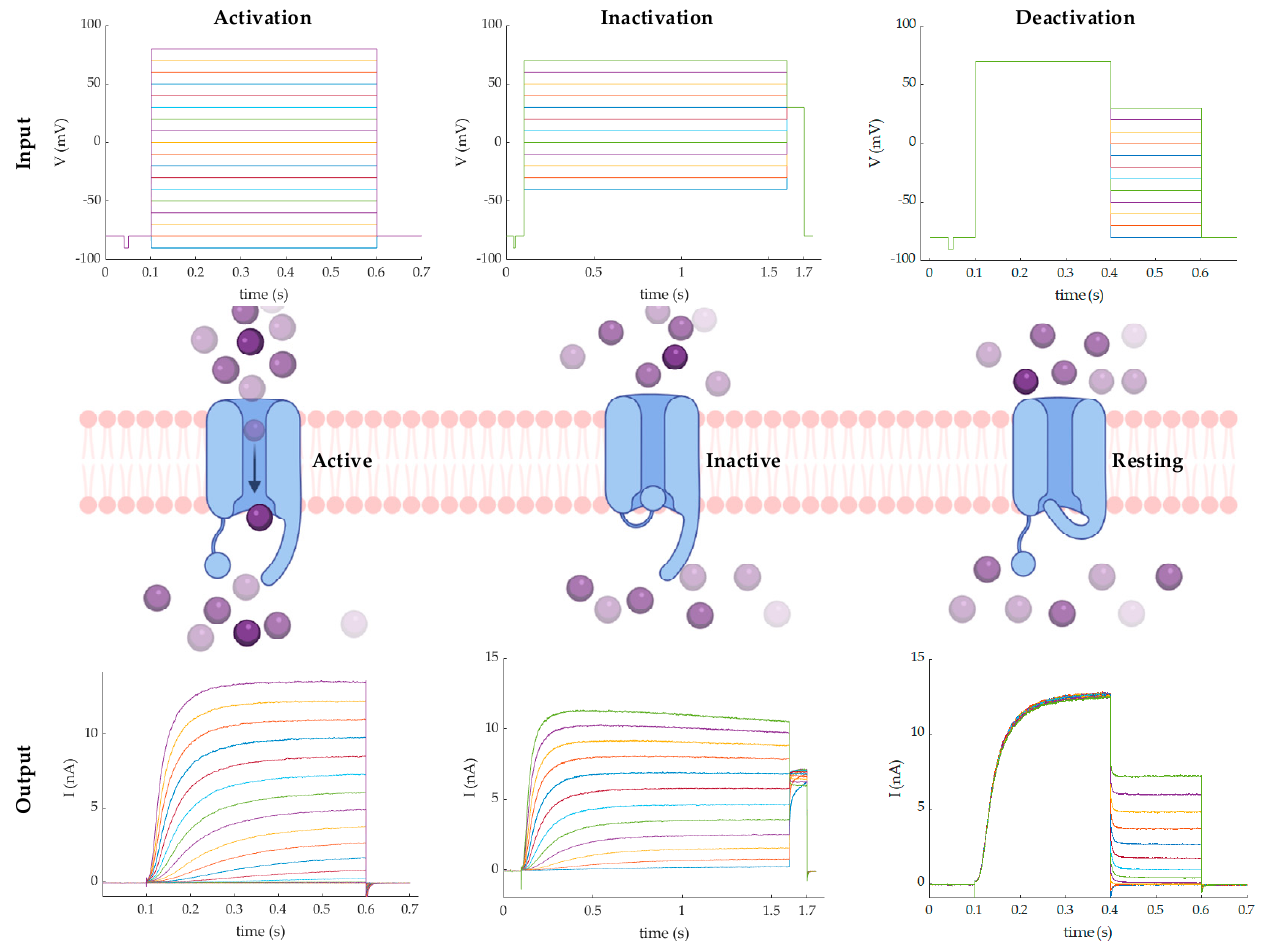
Figure 3. Dynamic behavior of the voltage-gated ion channel Kv10.1. Created with BioRender.